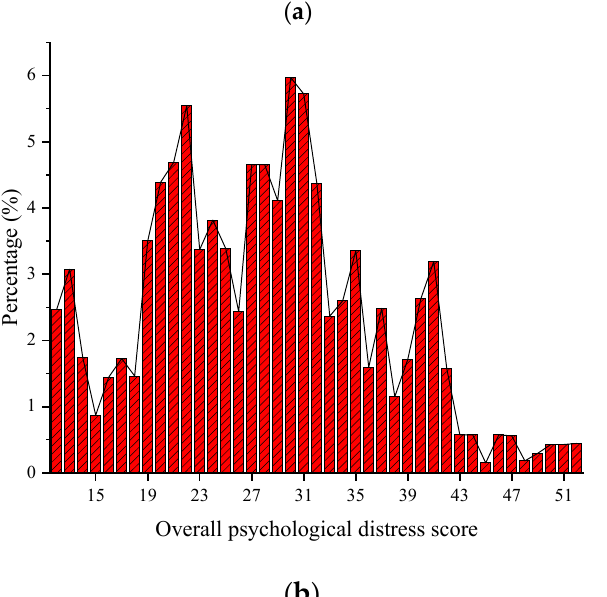
Figure 4. Histogram of positive mental health and mental distress scores of surveyed residents. ( a ) Distribution map of overall mentally positive health scores. ( b ) Distribution map of overall mental distress scores.